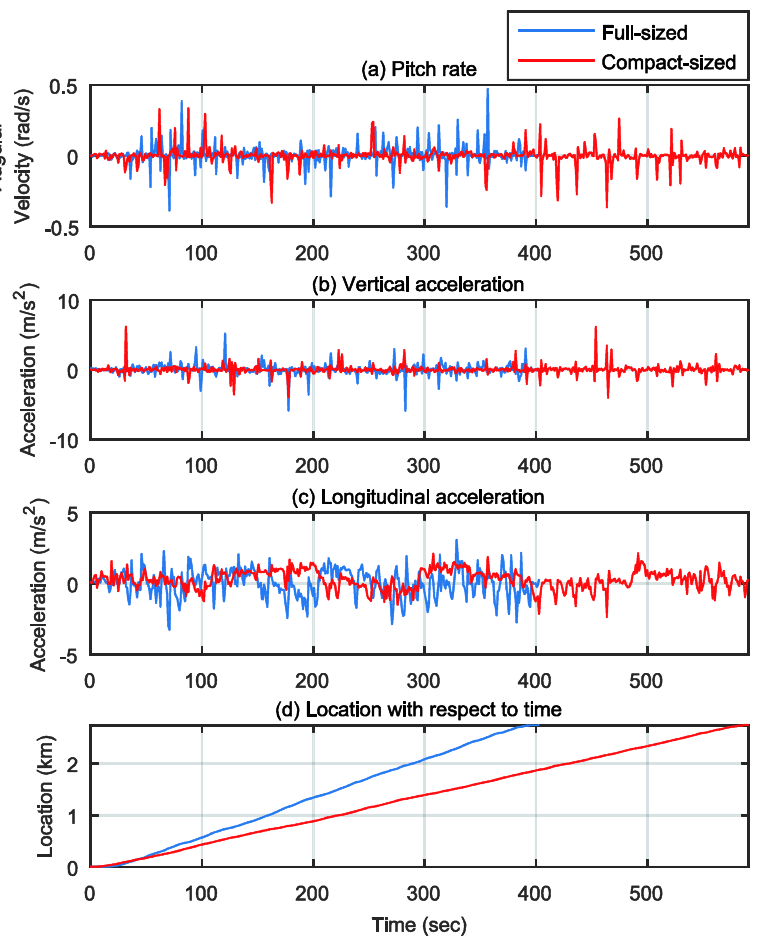
Figure 13. Measured signals from IMU sensor: ( a ) Pitch rate signals; ( b ) Vertical acceleration signals; ( c ) Longitudinal acceleration signals; ( d ) Location with respect to time.